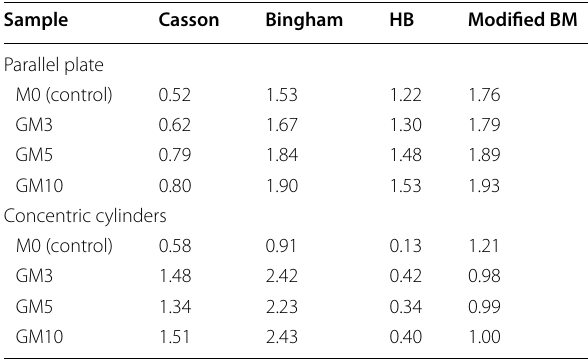
Table 4 Effect of graphene percentage on yield stress